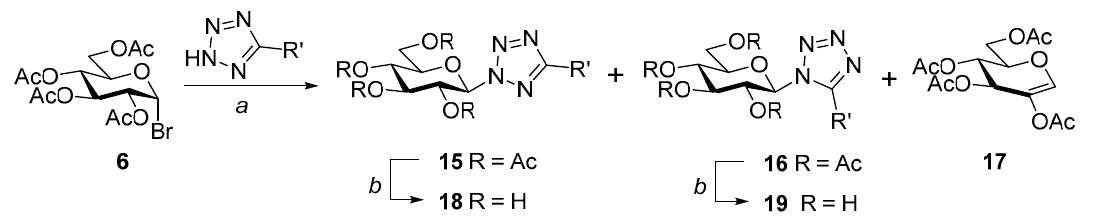
Reagents and conditions: ( a ) K 2 CO 3 , 4 Å molecular sieves, dry acetone, reflux; ( b ) ~1 M NaOMe in MeOH,